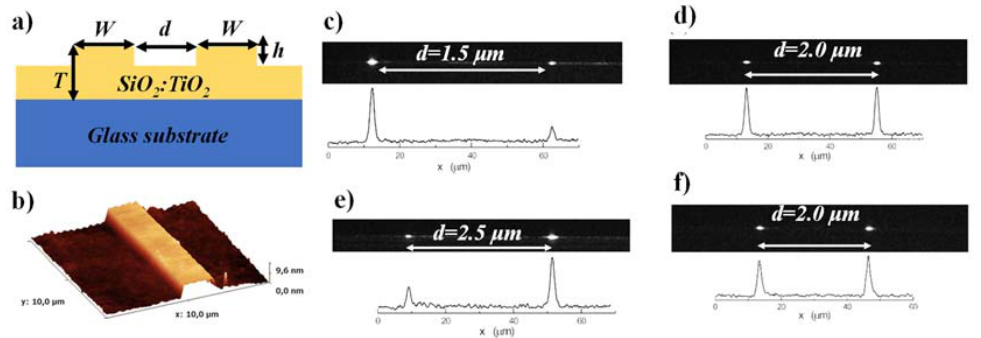
Figure 11. ( a ) Cross-sectional view of the directional coupler based on SiO 2 -TiO 2 platform, ( b ) Atomic force microscopy of the rib WG. Adapted with permission from [184]. Near-field image of a 1 × 2 DC and related distributed optical power when the coupling length ( L ), ( c ) 1.5 mm, ( d ) 3.0 mm, ( e ) 3.0 mm, ( f ) 4.5 mm. Adapted with permission from [184].